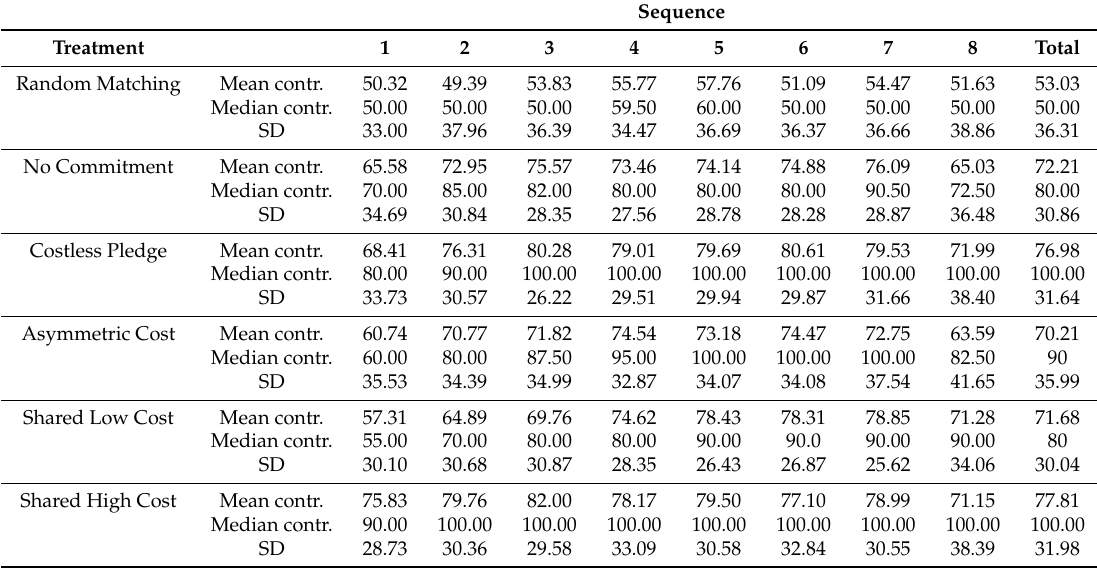
Table 6. Summary of contribution behaviour by sequence and